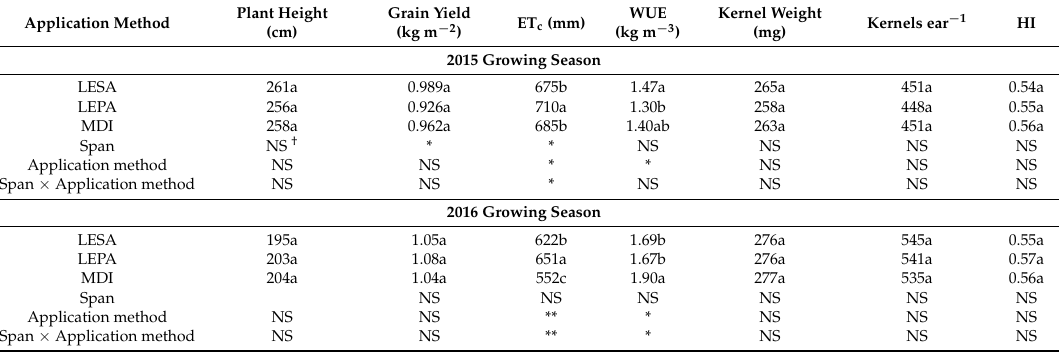
Table 4. Mean measurements ( n = 6) of soil water content and crop response for the 2015 and 2016 growing season for corn hybrid, P9697AM, in Bushland, TX, USA. Grain yield is presented on a dry basis. In each category, mean values followed by the same letters are not significantly different for p <